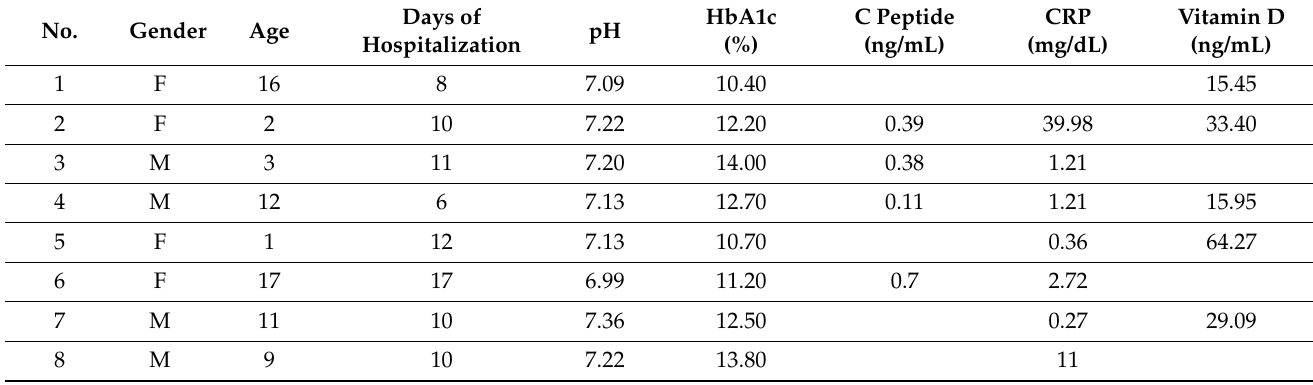
Table 7. Characteristics of the patients presenting SARS-CoV-2 inffection at the time of diagnosis of T1DM.